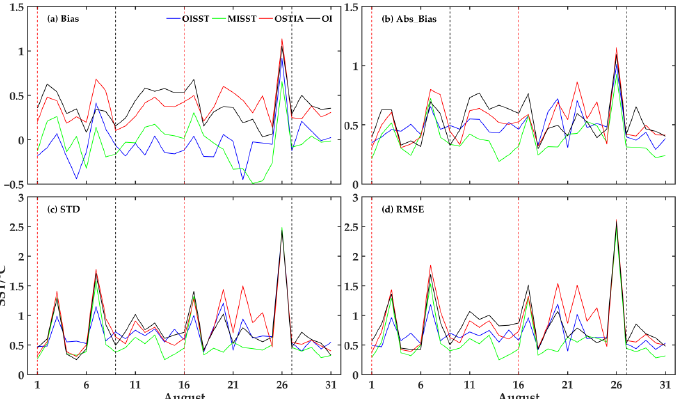
Figure 7. Day-by-day evolution of the statistical analysis of fusion products and Argo buoy SST match points. ( a) Average of the mean deviation between the four products at the matching point and the buoy value, ( b ), ( c ) and ( d ) as in ( a ), but is the mean for absolute deviation, standard deviation, root mean square error respectively. The red vertical line indicates the date when the typhoon started to affect, and the black line indicates the date when the effect ended.